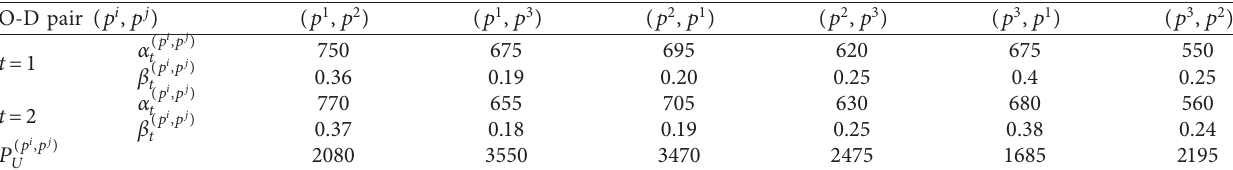
Table 3: Estimation and variation of demand function coefficients and price limit in free